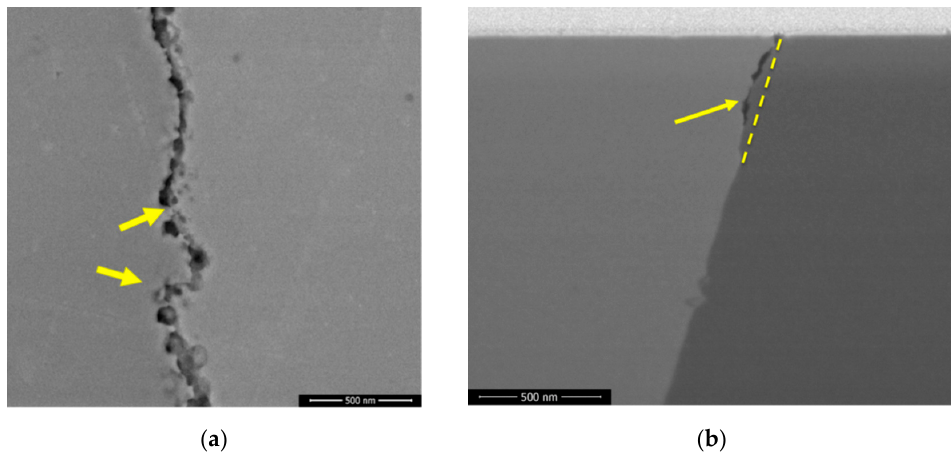
Figure 5. SEM-BSE images of Alloy 600, originally with polished surface, after its exposure for 1000 h to simulated PWR water (of 40 cc/kg H 2 , i.e., in the Ni stability region, and at 320 °C), with no applied stress, showing: ( a ) GB undulations on the surface (indicated by arrows) and ( b ) in cross-section a GB oxidation (where the dark imaging penetration, indicated by an arrow, has been confirmed to be Cr 2 O 3 ) and GB migration (where a dashed line marks the GB original position). Reprinted from the open-access publication [53].